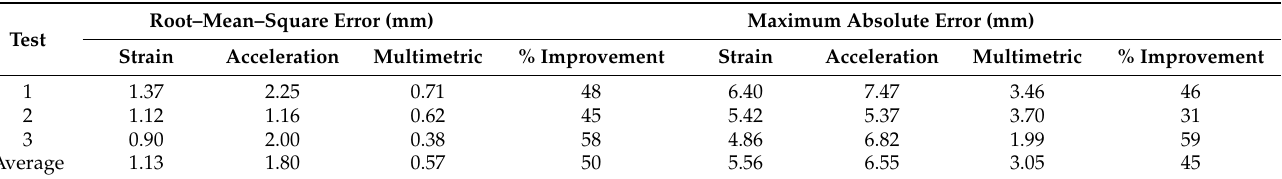
Table 3. Comparison of estimated first-story